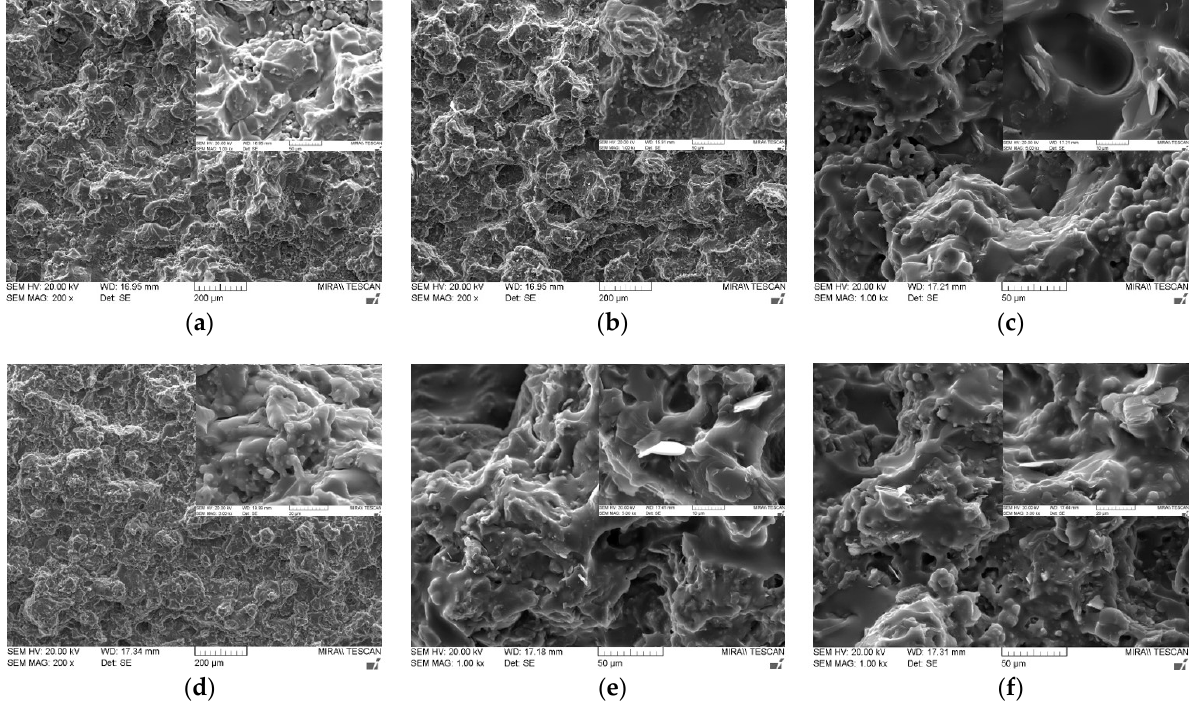
Figure 6. SEM images of bimodal and trimodal adhesives consisting of combined MgO and BN: ( a ) Bi ‐ MgO ‐ 1 (120 μ m MgO/90 μ m MgO); ( b ) Bi ‐ MgO ‐ 4 (120 μ m MgO/0.6 μ m MgO); ( c ) Bi ‐ MgO/BN ‐ 4 (120 μ m MgO/280 μ m BN; ( d ) Tri ‐ MgO ‐ 2 (120 μ m MgO/90 μ m MgO/6 μ m MgO); ( e ) Tri ‐ MgO2/BN1 ‐ 3 (120 μ m MgO/90 μ m MgO/12 μ m BN); ( f ) Tri ‐ MgO1/BN2 ‐ 3 (120 μ m MgO/12 μ m BN/280 μ mBN).